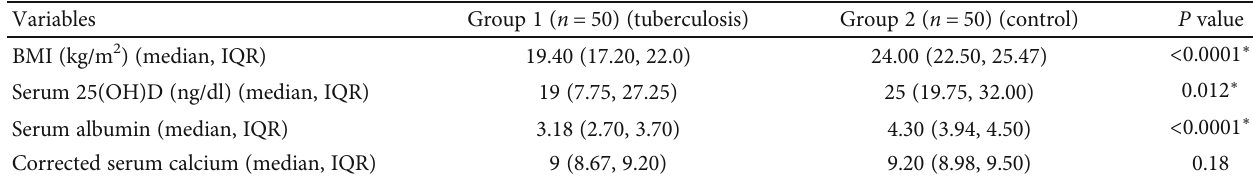
Table 1: Determinants of pulmonary tuberculosis.